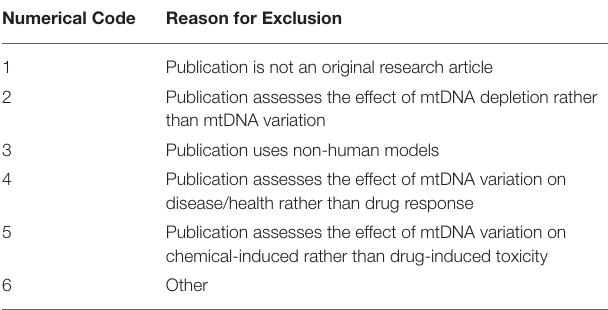
TABLE 2 | Summary of full-text article exclusion criteria with assigned numerical coding. Numerical